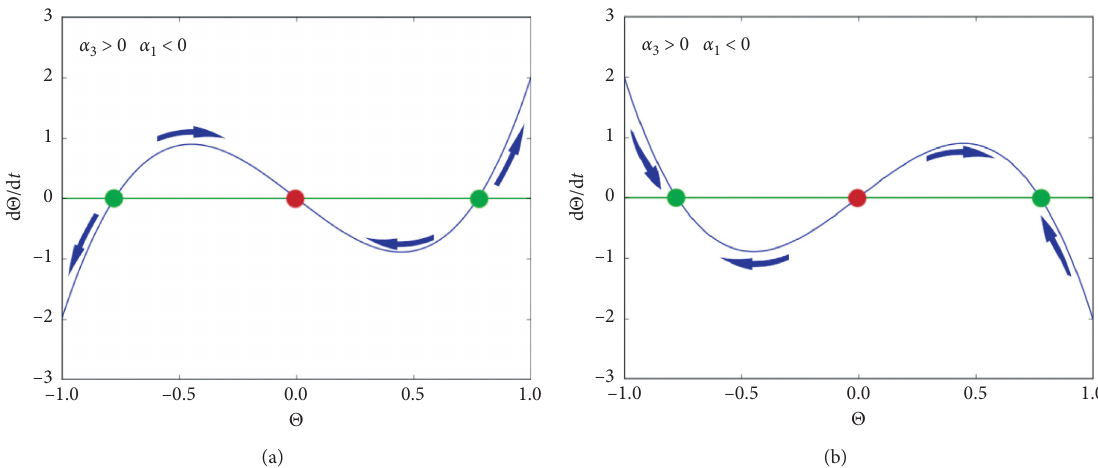
� α � 0 for two different parameters constellation for α 0 2